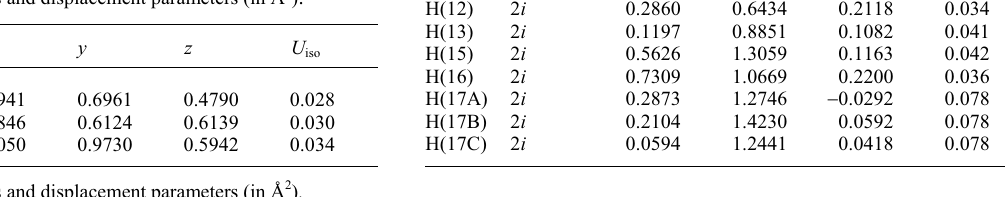
Table 2. Atomic coordinates and displacement parameters (in Å 2 ) .